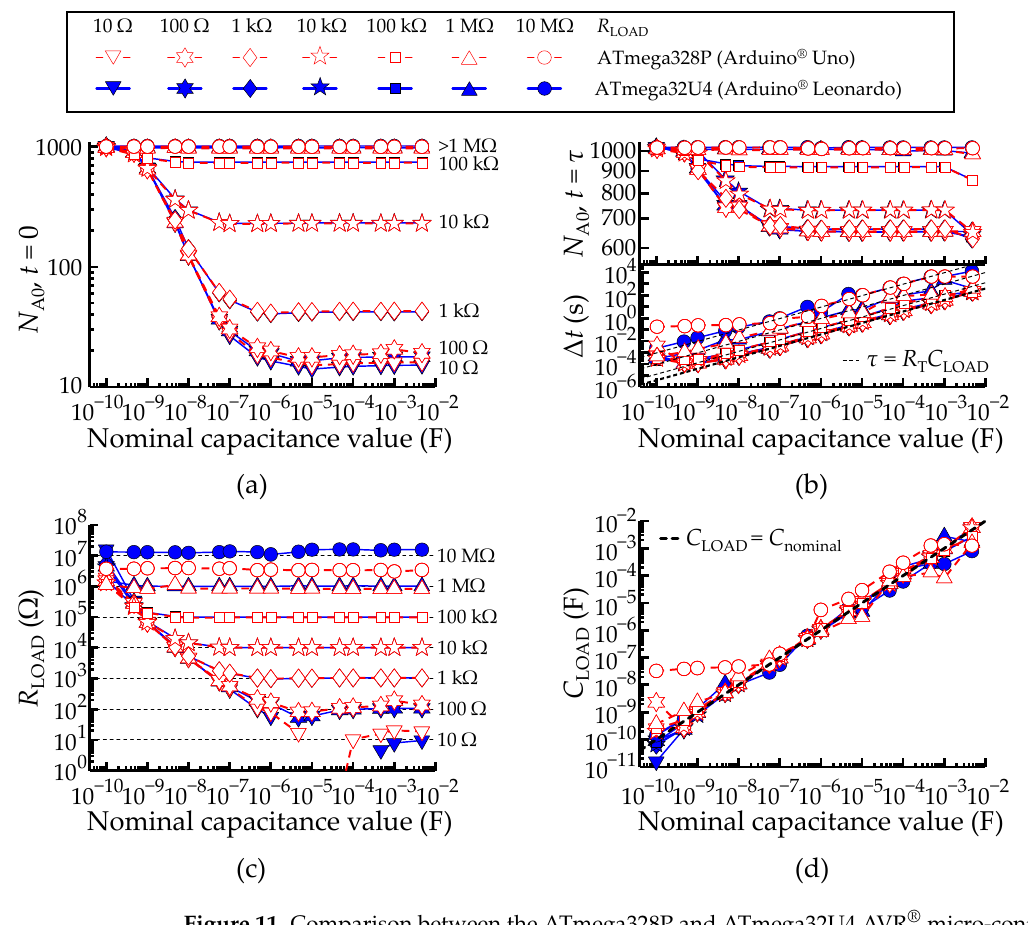
Figure 11. Comparison between the ATmega328P and ATmega32U4 AVR ® micro-controllers configured to measure a serial RC network. ( a ) Measured ADC value at t = 0. ( b ) Measured ADC value and time ( Δ t ) until V A1 ≥ V C . ( c , d ) Obtained R LOAD and C LOAD values according to Equations (2) and (10), respectively. A legend to describe the color scheme used in all plots of Figure 11 was included. The black dashed lines always represent the theoretical lines.